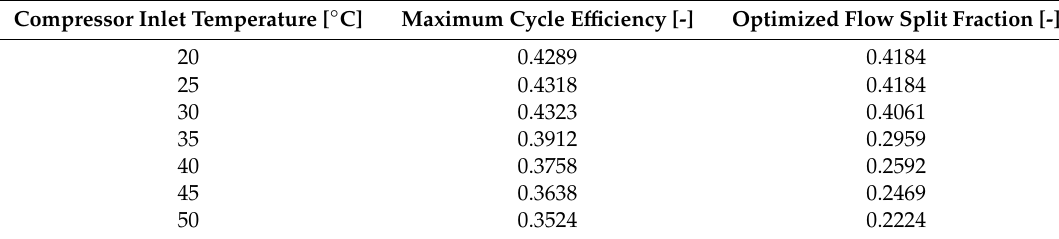
Table 3. Optimized flow split versus compressor inlet temperature (Compressor inlet pressure 7.4 MPa, outlet pressure 20 MPa and turbine inlet temperature 487